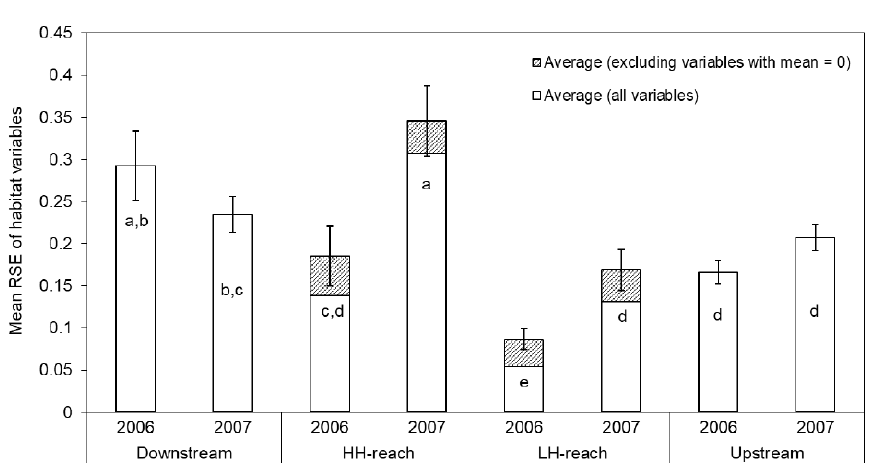
Figure C1. Mean relative standard error (RSE = standard error/mean) values across all quantitative variables measured in each sampling reach and year. Higher values reflect greater variability, or heterogeneity, between the 10 transects sampled in each reach and year relative to the mean value measured in those transects. Included variables are shown in Table C1. Error bars show ± 1 SE for crosshatched bars. Groups with the same letter (i.e., a–e) are not significantly different ( α = 0.05) according to Duncan’s Multiple Range Test.